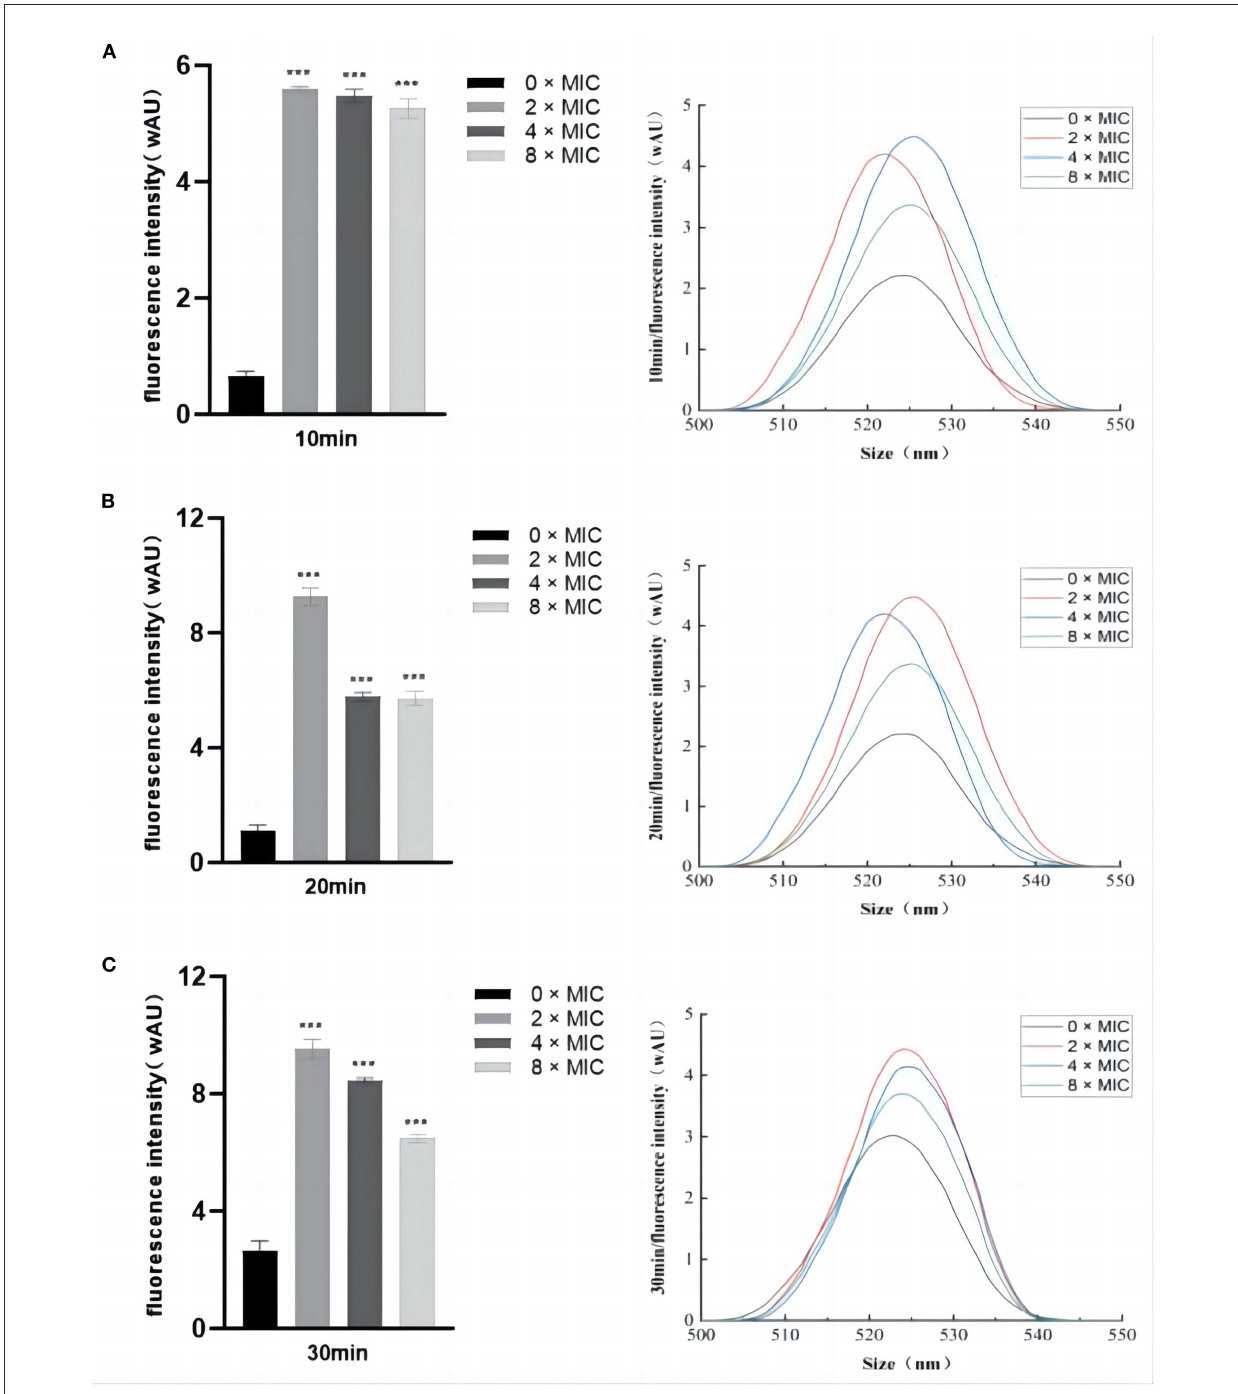
FIGURE4 Differences in the fluorescence intensity of ROS. (A) Determination of SA intracellular ROS levels after SGCH treatment for 10min; (B) Determination of SA intracellular ROS levels after SGCH treatment for 20min; (C) Determination of SA intracellular ROS levels after SGCH treatment for 30min. *** p <